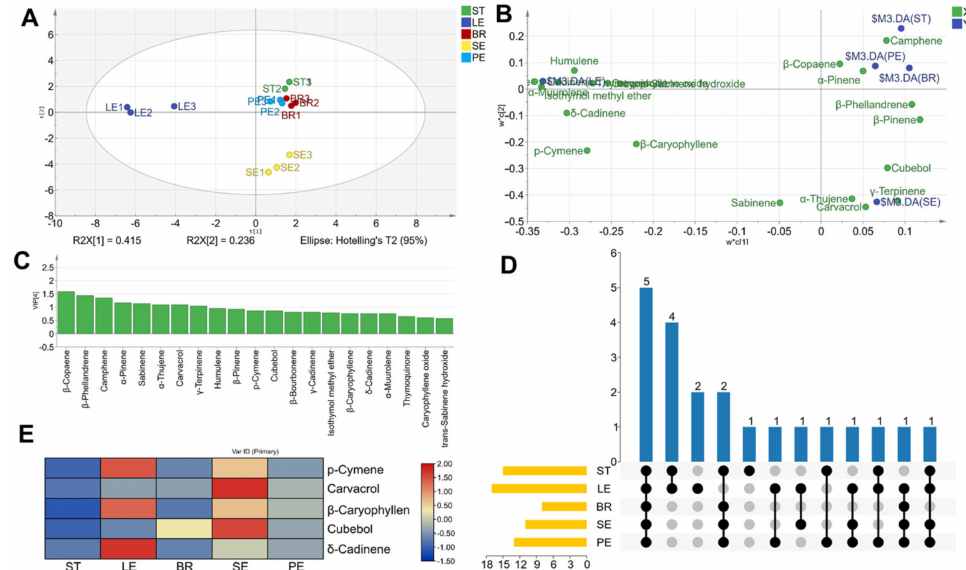
Figure 2. Analysis of volatile organic compounds from different tissues of Origanum vulgare ‘Hot and Spicy’. Score plot ( A ), loading plot ( B ), and variable importance in projection values ( C ) from PLS-DA model based on the chemical profiles of all samples. UpSet plot ( D ) and shared component Heatmap ( E ) based on the volatile organic compounds from different tissues of Origanum vulgare ‘Hot and